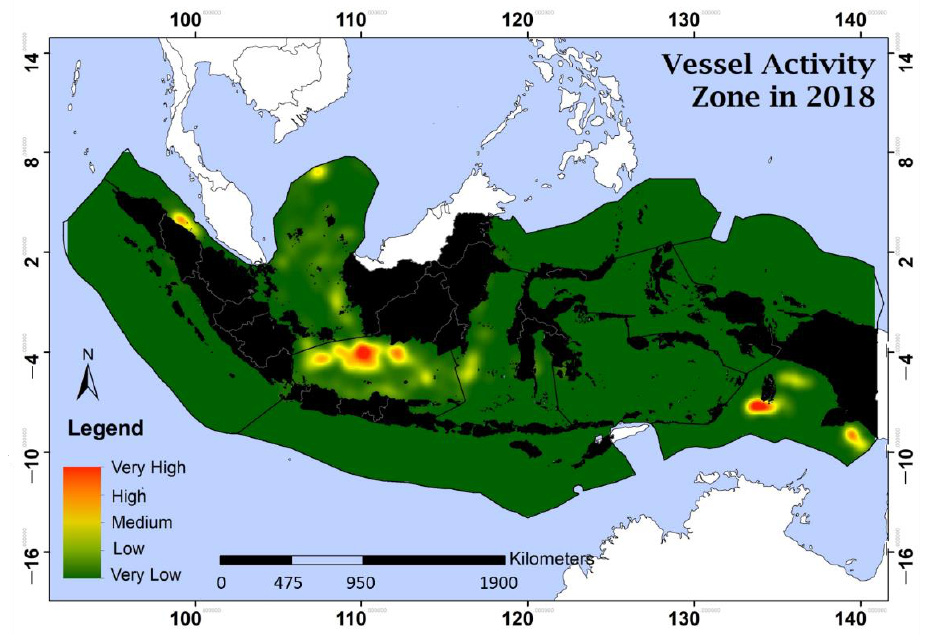
Figure 9. Average vessel activity zones in 2018.